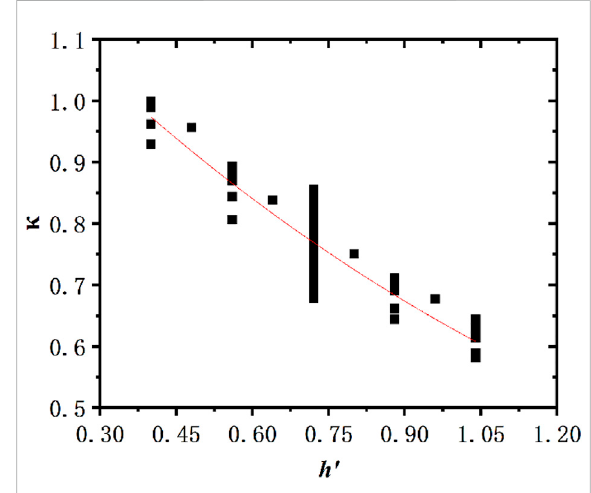
Figure 6 Curves of b ′ versus l ′ for different models.